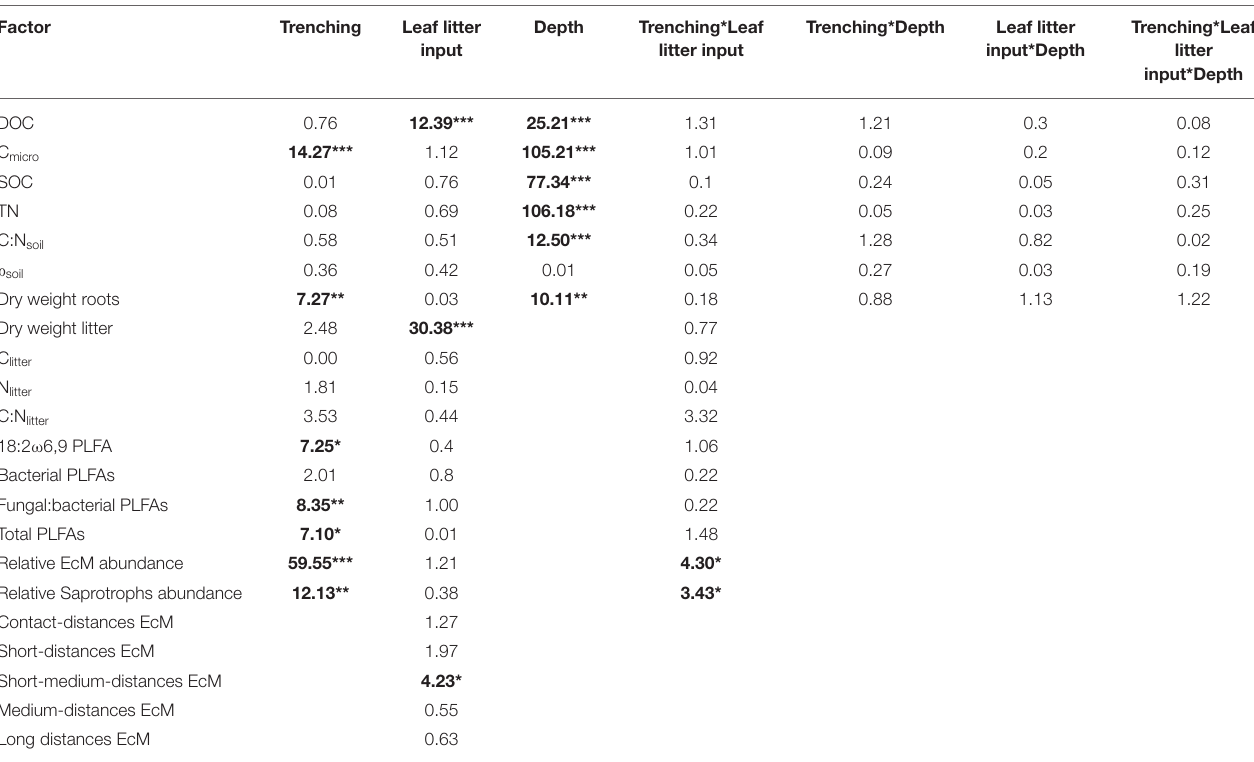
TABLE 2 | Results of the ANOVAs on soil and microbial fractions and root and leaf litter variables. Factor